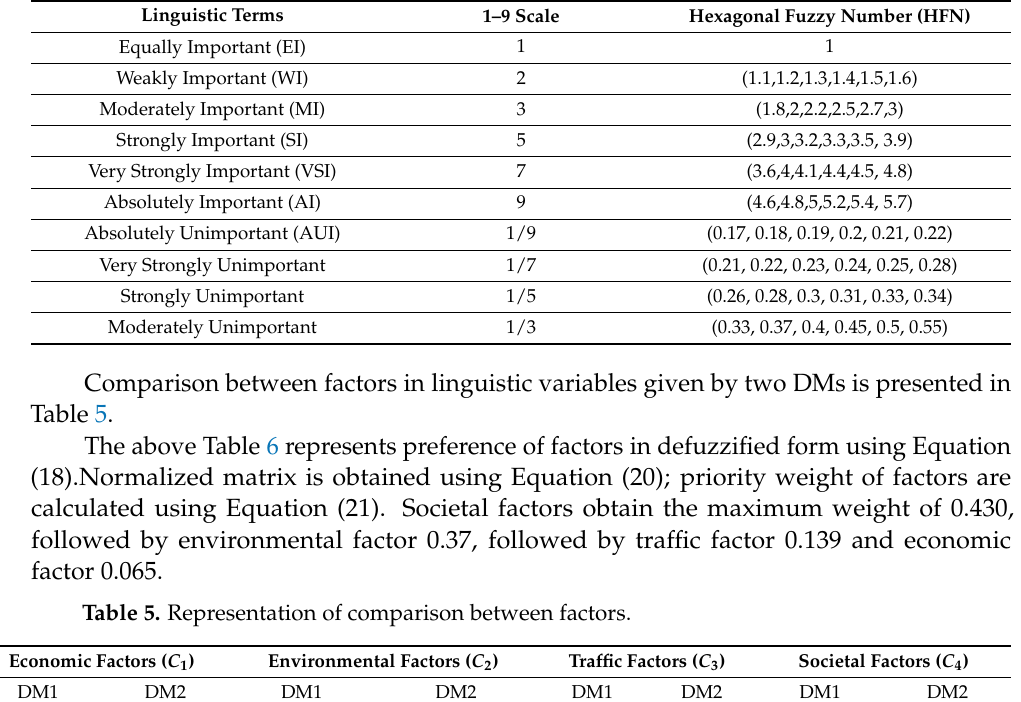
Table 4. Linguistic term in HFN 1–9 scale.